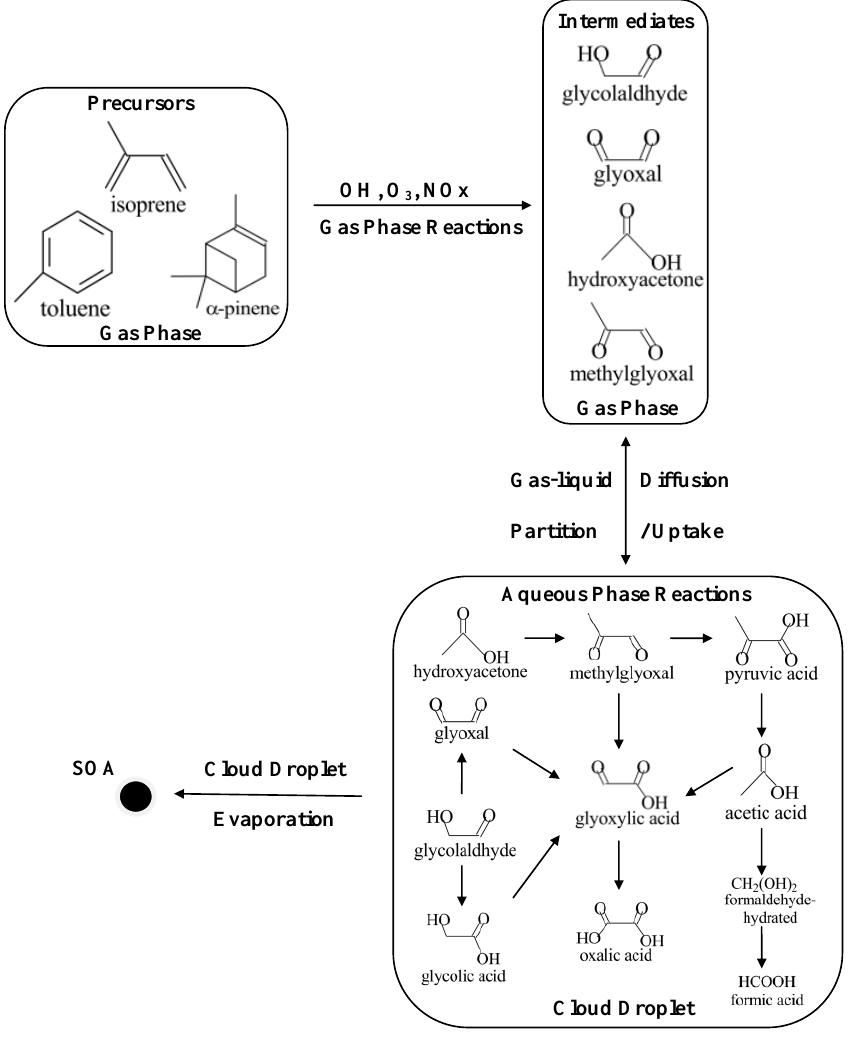
Fig. 1. Chemical mechanism for aqueous-phase formation of